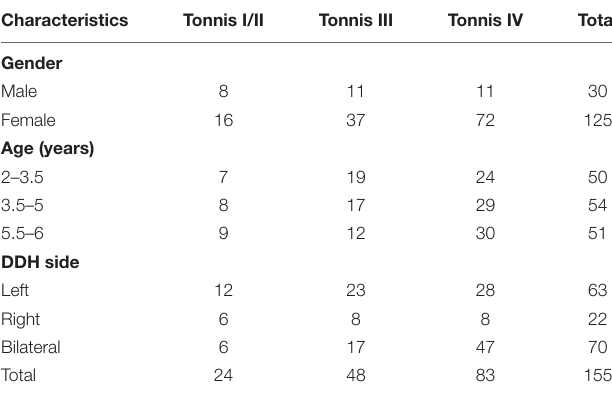
TABLE 1 | Primers used for amplification of target genes and β -actin. F-Sequence (5 (cid:48) -3 (cid:48) ) R-Sequence (5 (cid:48) -3 (cid:48) ) Collagen I GGGAACATCCTCCTTCAACAG